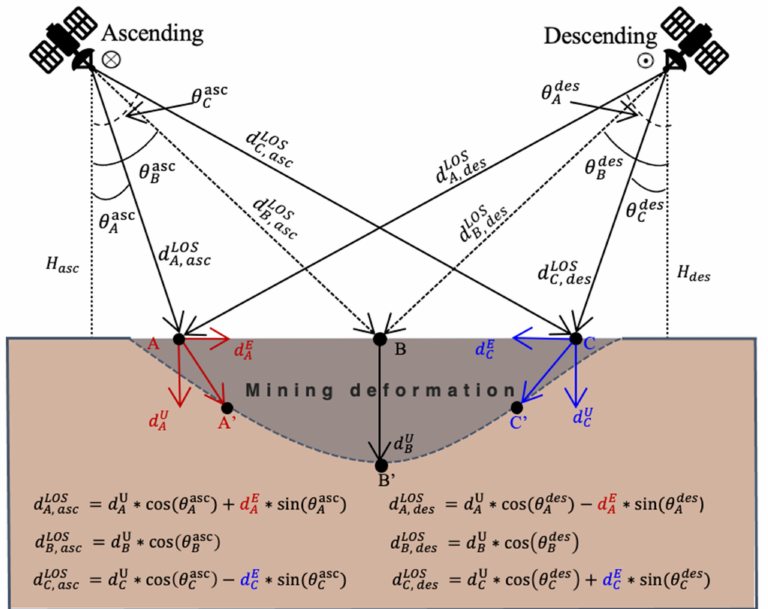
Figure 11. Schematic diagram of mining deformation monitoring with multiplatform SAR from ascending and descending orbital